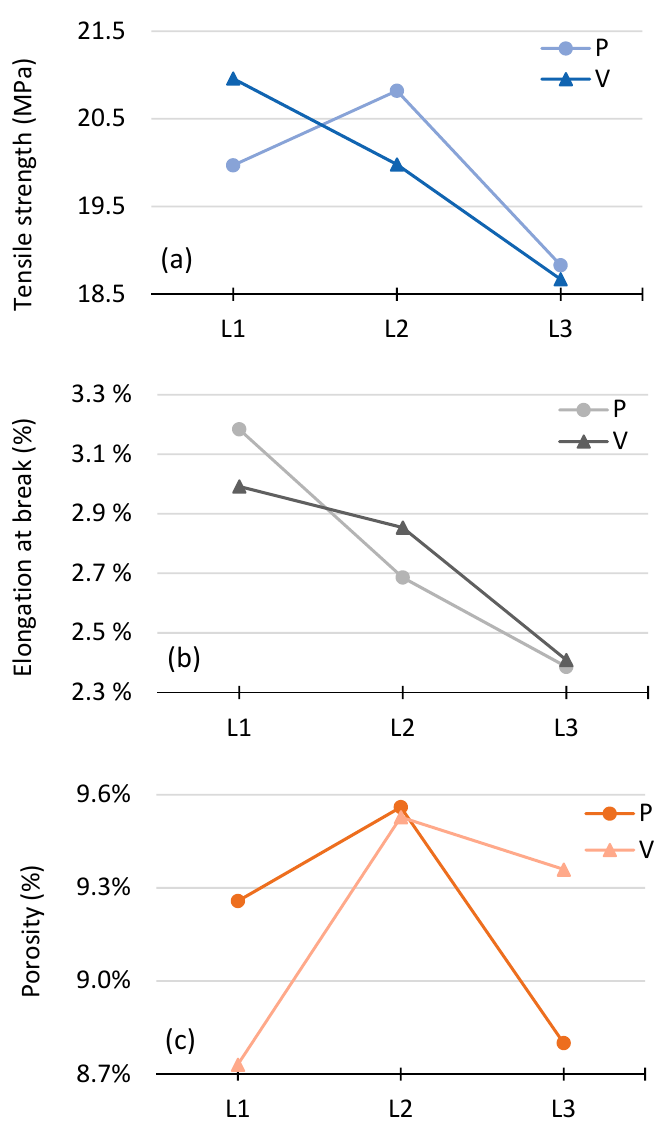
Figure 11. Main effect plot for means of ( a ) tensile strength; ( b ) elongation at break; and ( c ) porosity. As part of the design of experiment (DOE), an analysis of variance (ANOVA) test is conducted with a confidence level of 95% ( α = 0.05). The ANOVA test included both independent variables P and V . The ANOVA included all first order, second order, and interaction terms. The statistical significance of the terms can be assessed by looking at the test’s P -value. The more the P -value approaches zero